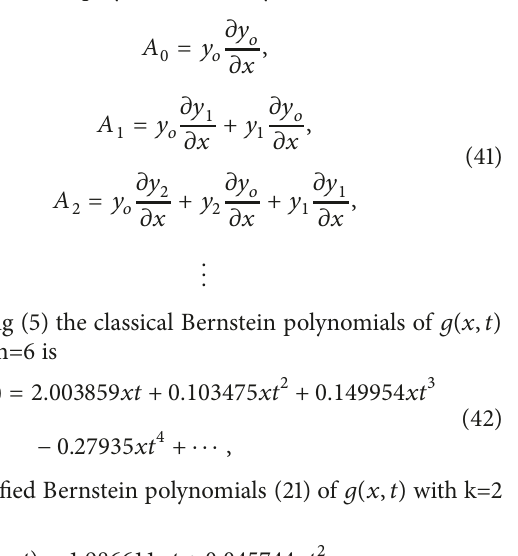
The Adomian polynomials for Ny